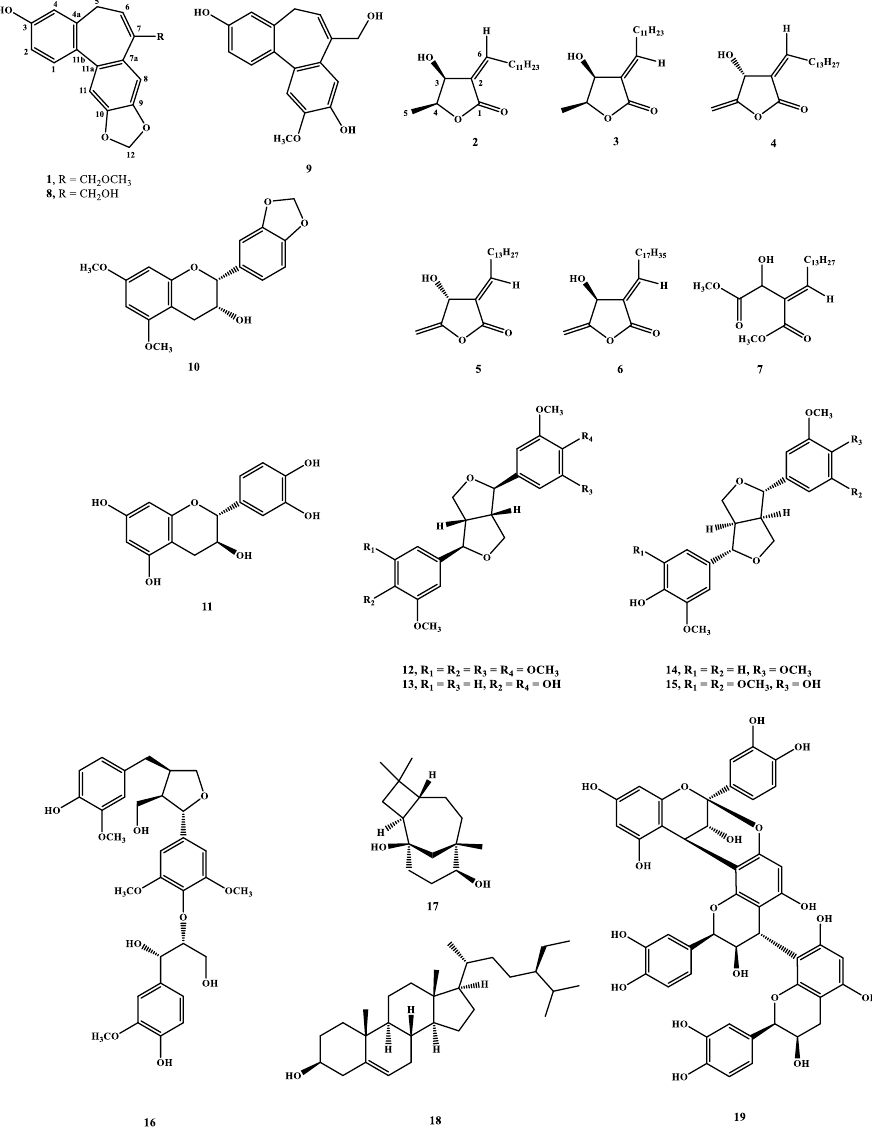
Figure 1. Structures of compounds 1 – 19 .